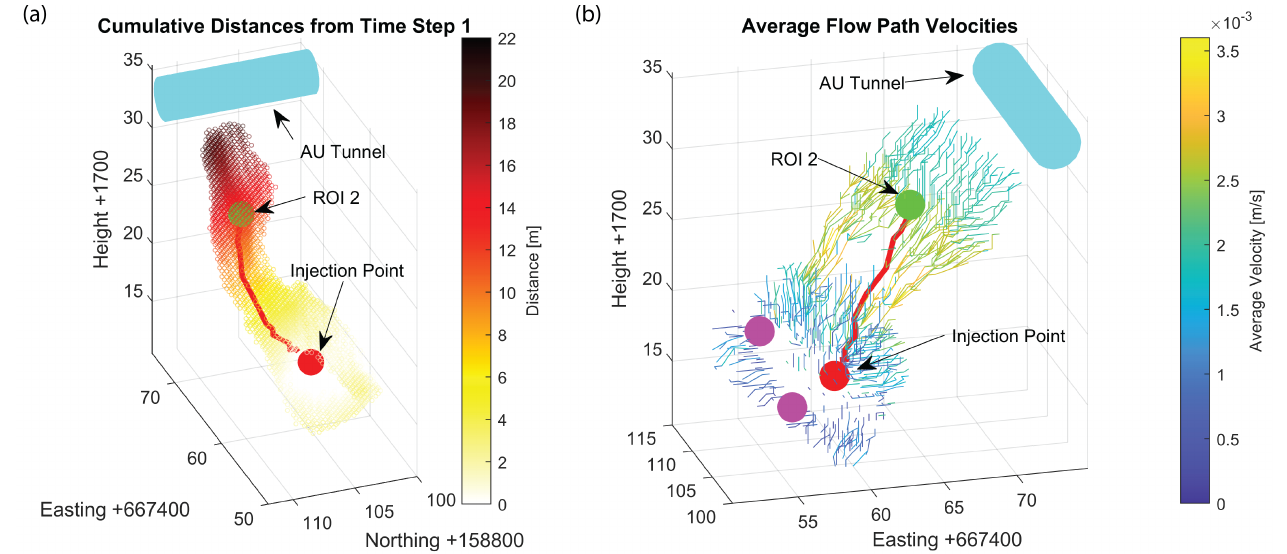
Figure 10. ( a ) Cumulative distances from the first time step and exemplary flow connection calculated with the routing algorithm towards a point in ROI 2 (green). ( b ) Various resulting flow path trajectories determined with the routing algorithm that are color-coded with their respective average velocity. Note that these flow paths do not represent the physical flow paths through the fracture network, but are only the reconstructed connections in order to determine apparent flow path distances and the average velocity along these. The spheres indicate the injection location (red), the PRP1.3 and PRP2.2 intervals (magenta), and a point in ROI 2 (green). As a reference, the AU tunnel is shown in